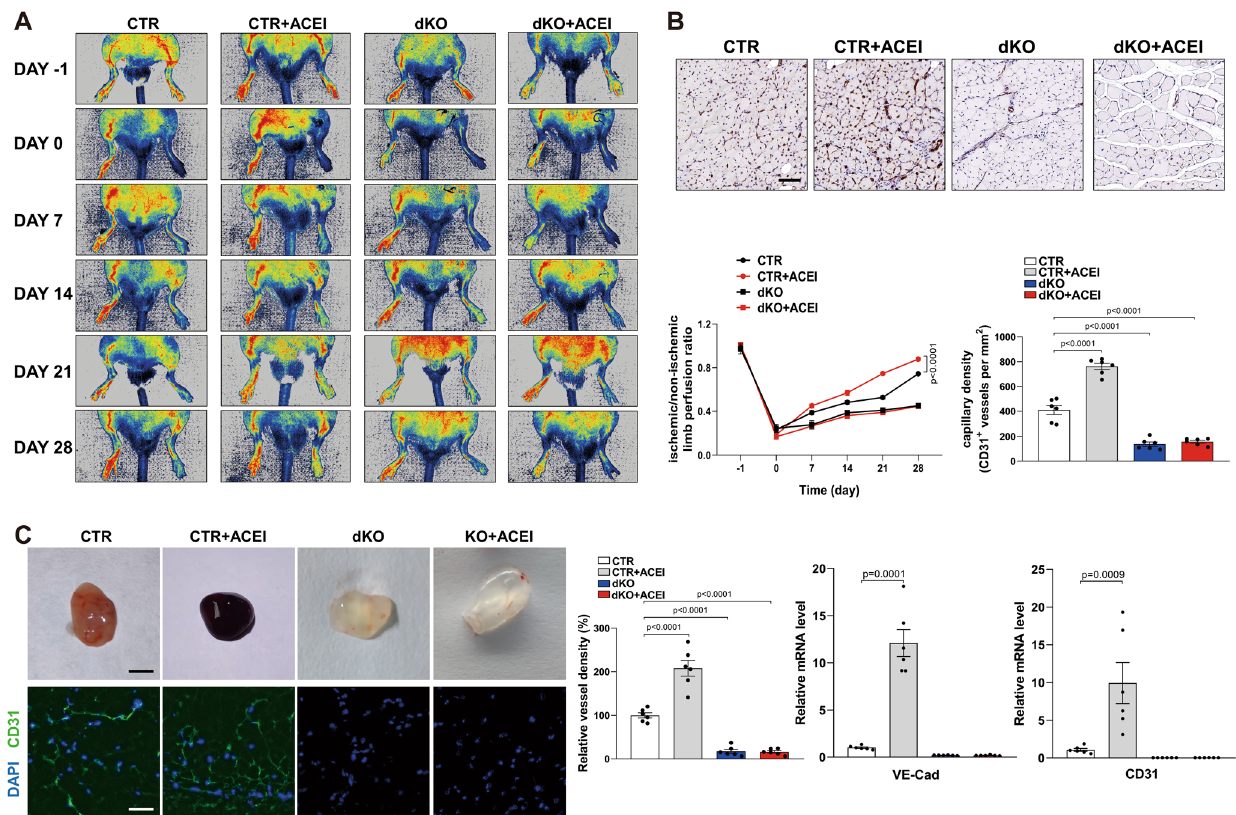
Fig. 3 | ACEIpromotespathological angiogenesis via Sp1/Sp3. A Representative laser Doppler images of the legs on day – 1 (before surgery), 0 (immediately after surgery), 7, 14, 21, and 28. Right, quanti fi cation of blood fl ow recovery after hin- dlimb ischemia as determined by the ratio of foot perfusion of the ischemic (left) and non-ischemic (right) legs in CTR and dKO mice treated with or without ACEI. n =6. B Assessment of capillary density by IHC analysis using CD31 + staining in the ischemic gastrocnemius muscle. Bottom, quanti fi cation of CD31 + vessels per mm 2 inCTRanddKOmicetreatedwithorwithoutACEI. n =6.Scalebar:50 μ m. C Images